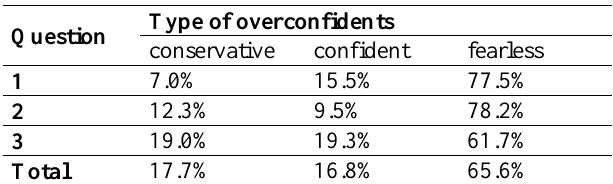
Table 8: Distribution of overconfident respondents by